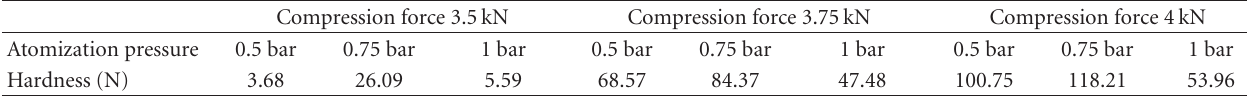
Table 7: Results of tablets hardness